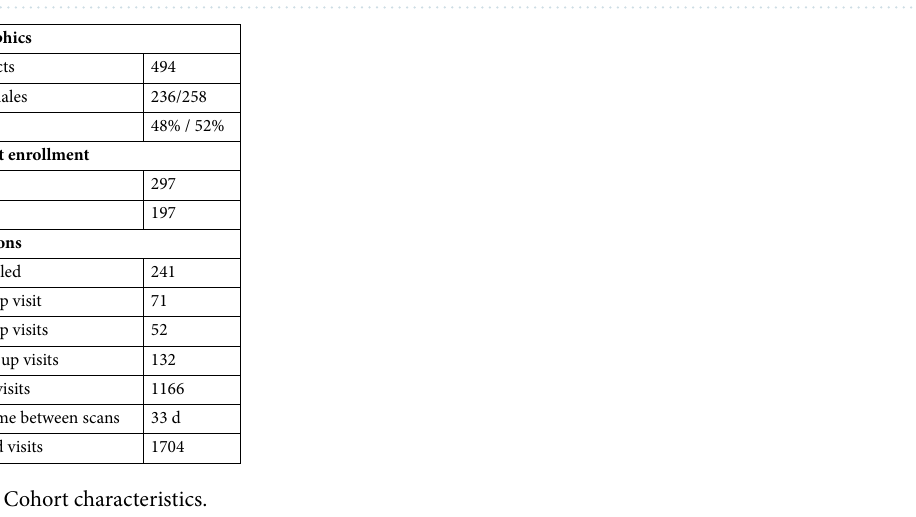
Figure 1. The biometric device and example imagery used in this study. ( A ) the device in use, ( B ) time-course images of a single subject’s finger, ( C ) binarized prints finger images, and (d) the internal components and design of the “Panda” device.